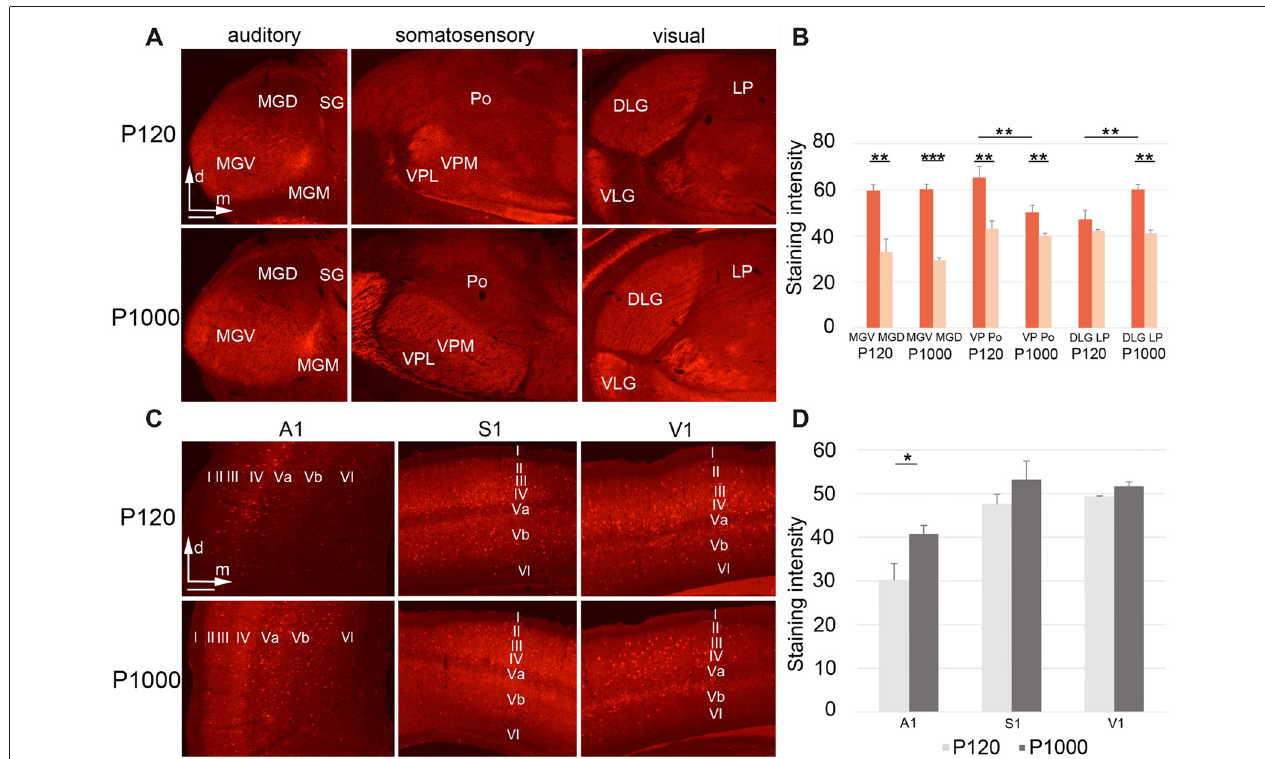
FIGURE 6 | During aging, Parvalbumin (PV) levels change differently in the sensory thalamic nuclei and cortical areas. (A,C) Frontal sections showing PV labeling in the auditory, somatosensory, and visual thalamic nuclei (A) and primary sensory cortices (C) at P120 and P1000. Scale bars 200 µ m. (B,D) Diagrams showing the staining intensities of PV in the sensory thalamus (B) and primary sensory cortices (D) at P120 and P1000. Note that the PV levels are always higher in lemniscal nuclei (MGV, VPL/VPM, DLG) than in non-lemniscal nuclei (MGD, Po, LP). Staining intensities are mean gray values ± 1 SEM; stars indicate significant changes between structures and/or experimental ages ( ∗ p ≤ 0.05, ∗∗ p ≤ 0.01, ∗∗∗ p ≤ 0.001, Student’s t -test; n = 9 sections per group). Abbreviations: A1, primary auditory cortex; D/VLG, dorsal/ventral lateral geniculate nucleus; LP, lateral posterior thalamic nucleus; MGD/M/V, dorsal/medial/ventral part of the MGB; Po,